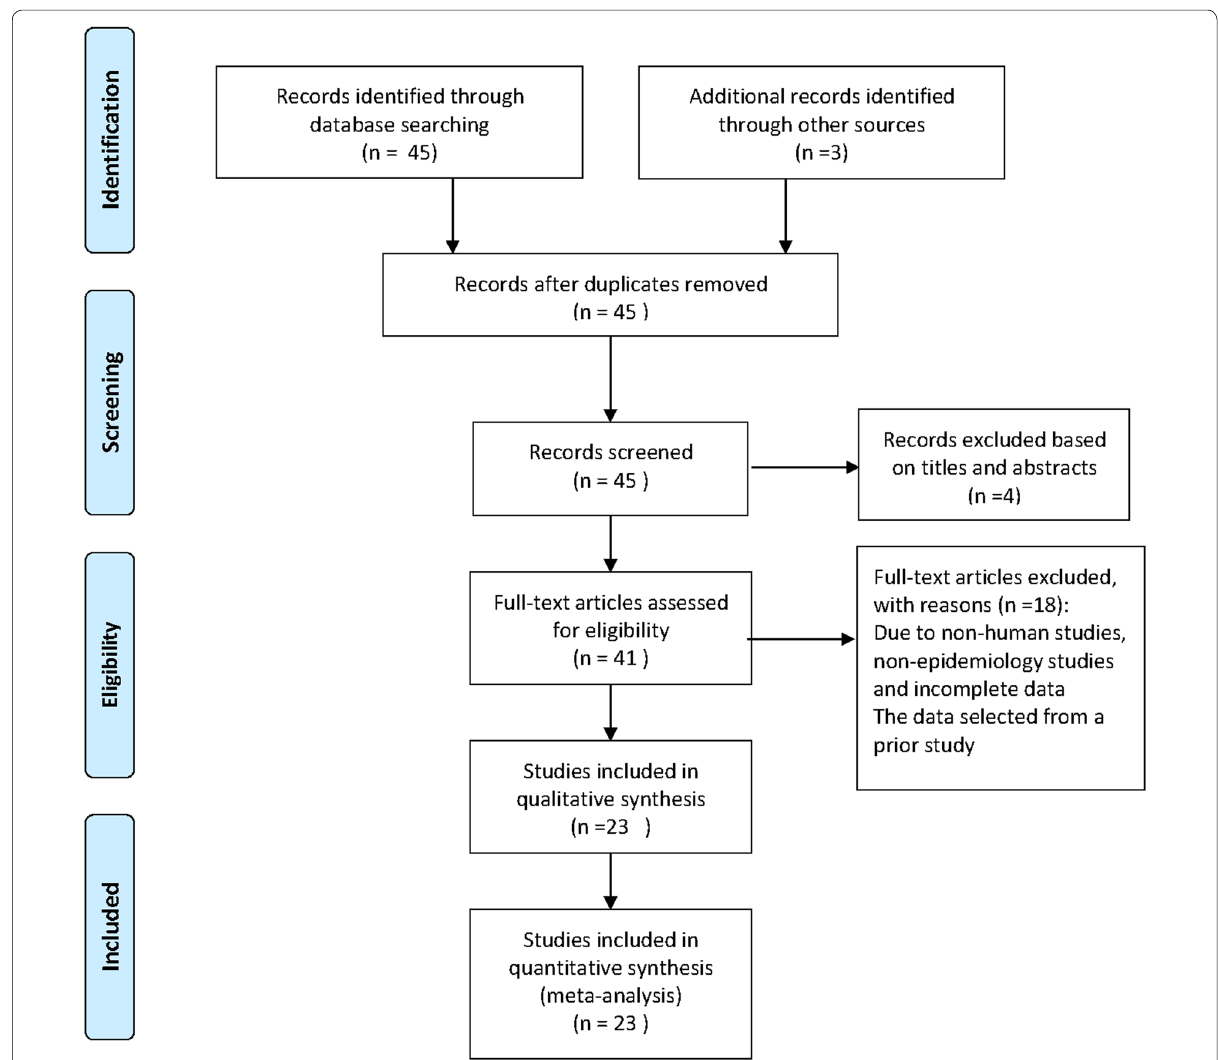
Fig. 1 Flow chart of screening and inclusion of studies for review and